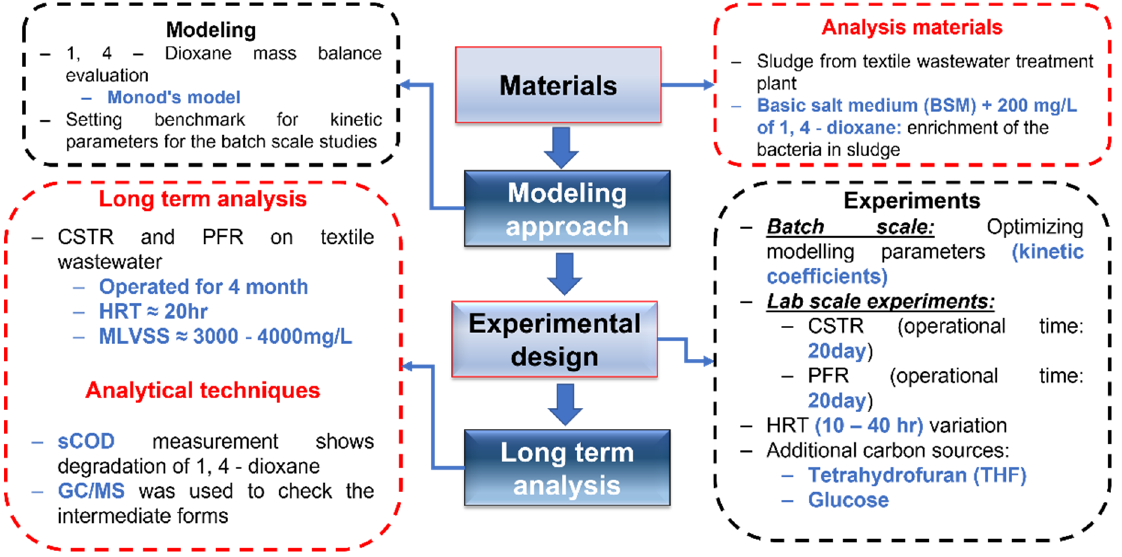
Figure 1. Schematic diagram of the experimental study .